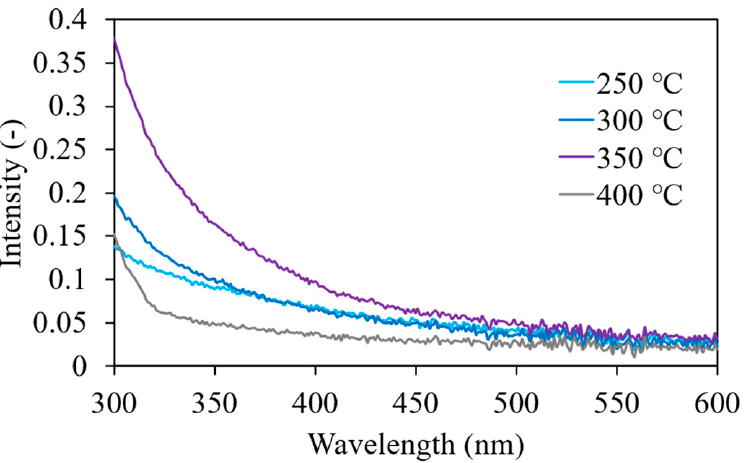
Figure 8. Absorption spectra obtained for the PHA-modified ZrO 2 nanoparticle–toluene dispersion synthesized at 250, 300, 350, and 400 °C.